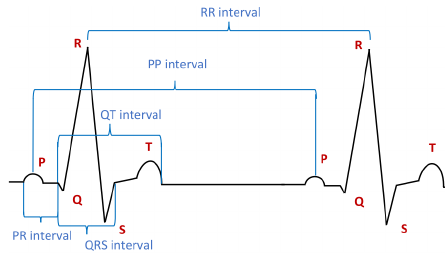
Figure 7. A normal ECG.